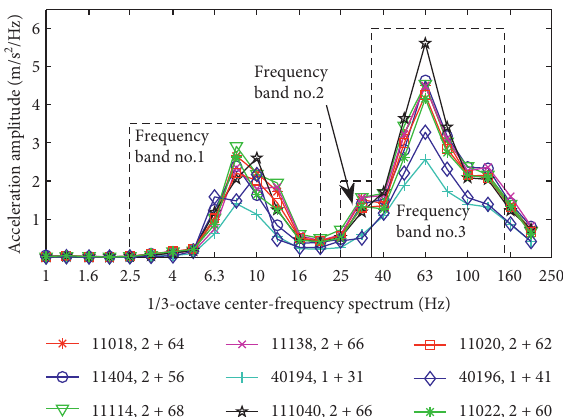
Figure 6: One-third-octave center-frequency spectrum induced by different vehicle marshallings ( P 4).